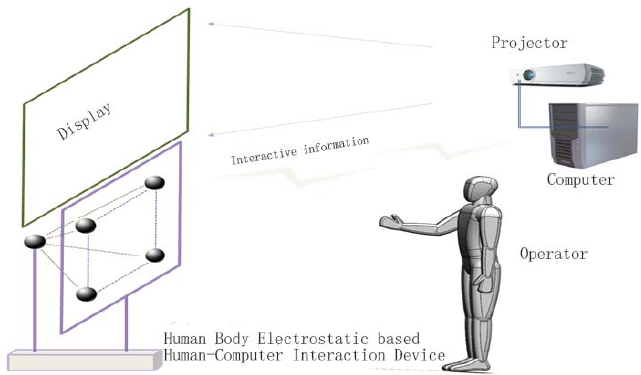
Figure 6. Schematic of human ‐ computer interaction (HCI) system based on the electrostatics of the human body.